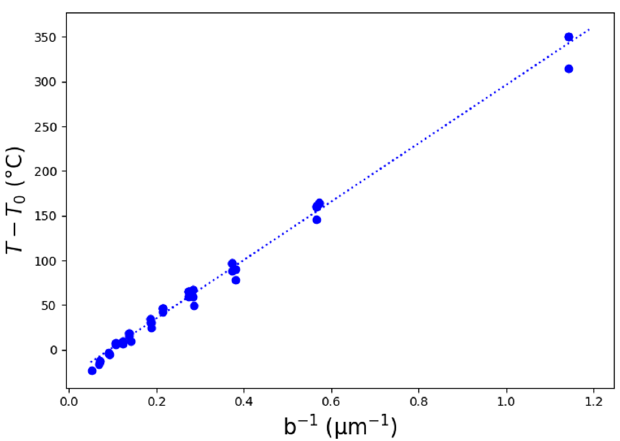
Figure 3. Simulation results of the temperature inside standing features with respect to the local width (b).